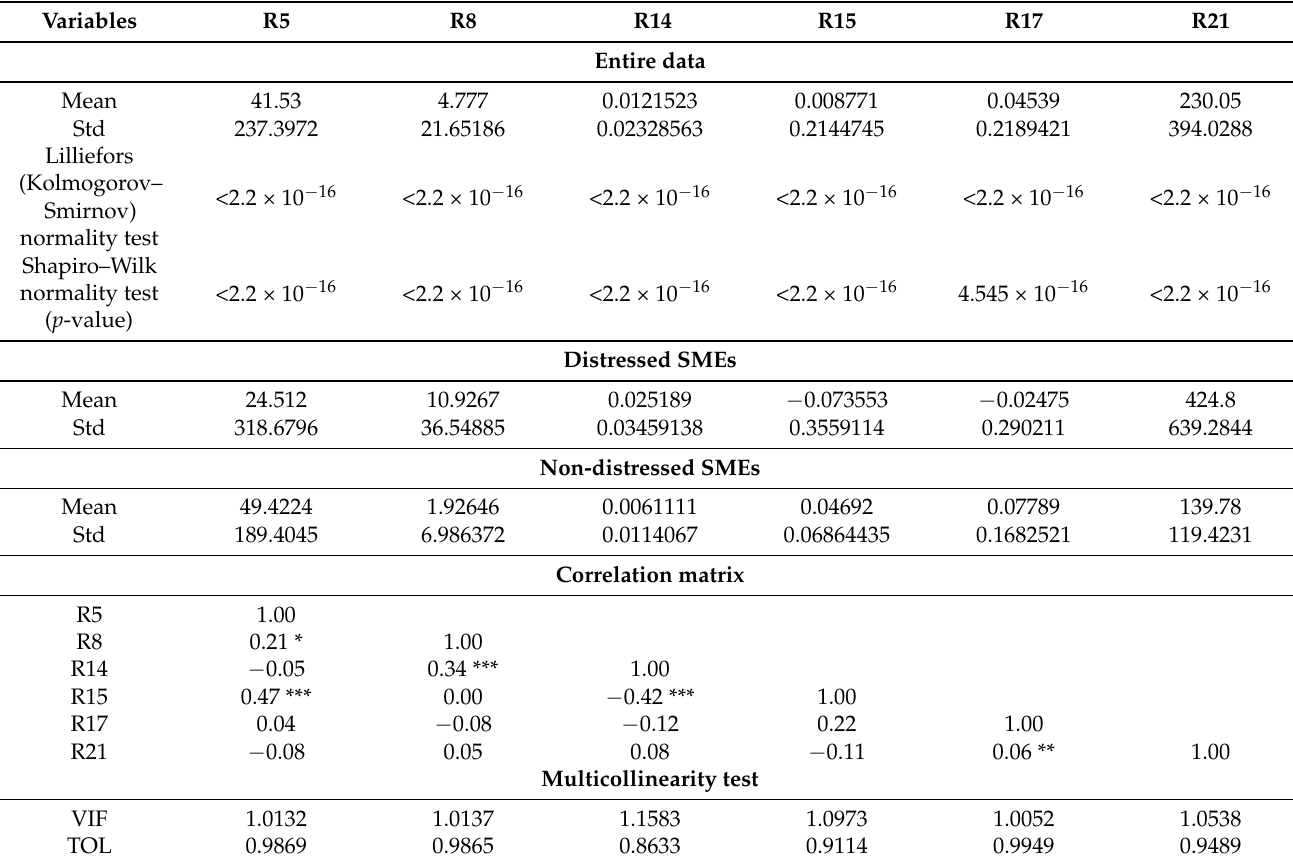
Table A3. Descriptive statistics for variables selected by stepwise technique, year